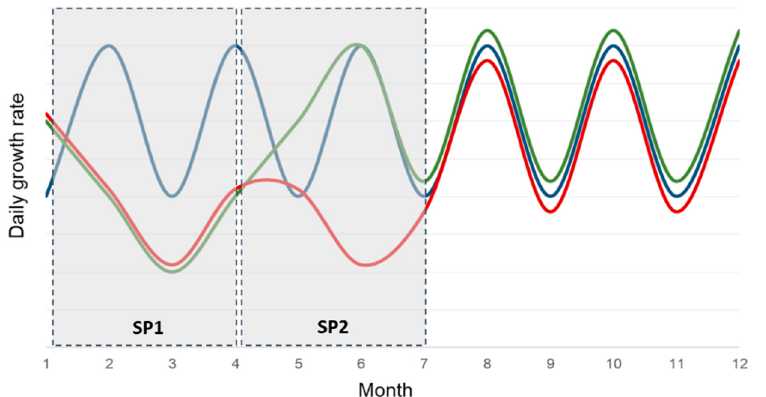
Figure 1. Plot for describing the three potential patterns of the daily growth of adult females of European hake, assuming lower growth when active spawning takes place (i.e., narrow daily rings in otoliths). Grey boxes: each spawning peak (SP1: winter-spring and SP2: summer). Red line: assuming that each female spawns in the two main spawning periods; Green line: assuming that each female participates only in one spawning peak (in this plot a female actively spawning only in SP1); and blue line: assuming that daily growth is not related to spawning activity.